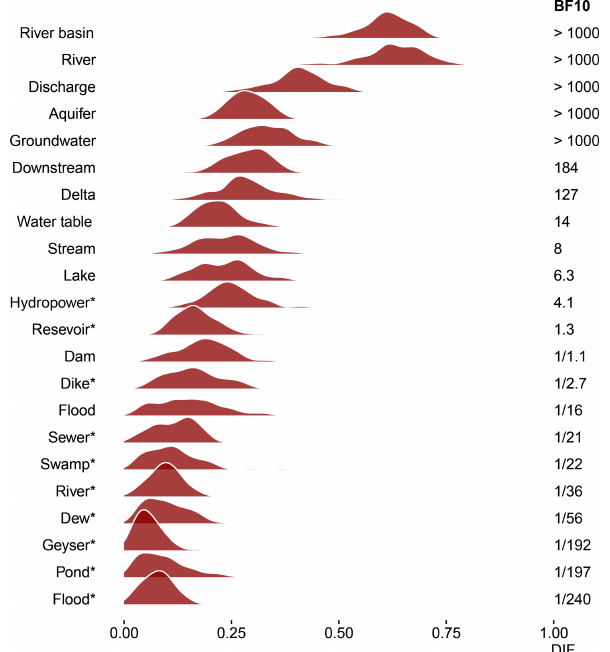
Figure 3. Graph showing the posterior distribution of the misfit be- tween laypeople and experts by using a Bayes factor (BF) for ev- ery term used in the survey. Pictorial questions are marked with an asterisk. A value of the BF < 1 / 10 is strong evidence towards H 0 : it is more likely that laypeople answer questions the same as experts than differently. A value of the BF > 10 is strong evidence towards H 1 : differences are more likely than similarities. In addi- tion to a Bayes factor for the significance of the difference, we also calculated the misfit: the strength of the difference. The misfit was calculated by a DIF score (differential item functioning), in which DIF = 0 means perfect match, and DIF = 1 means maximum differ-